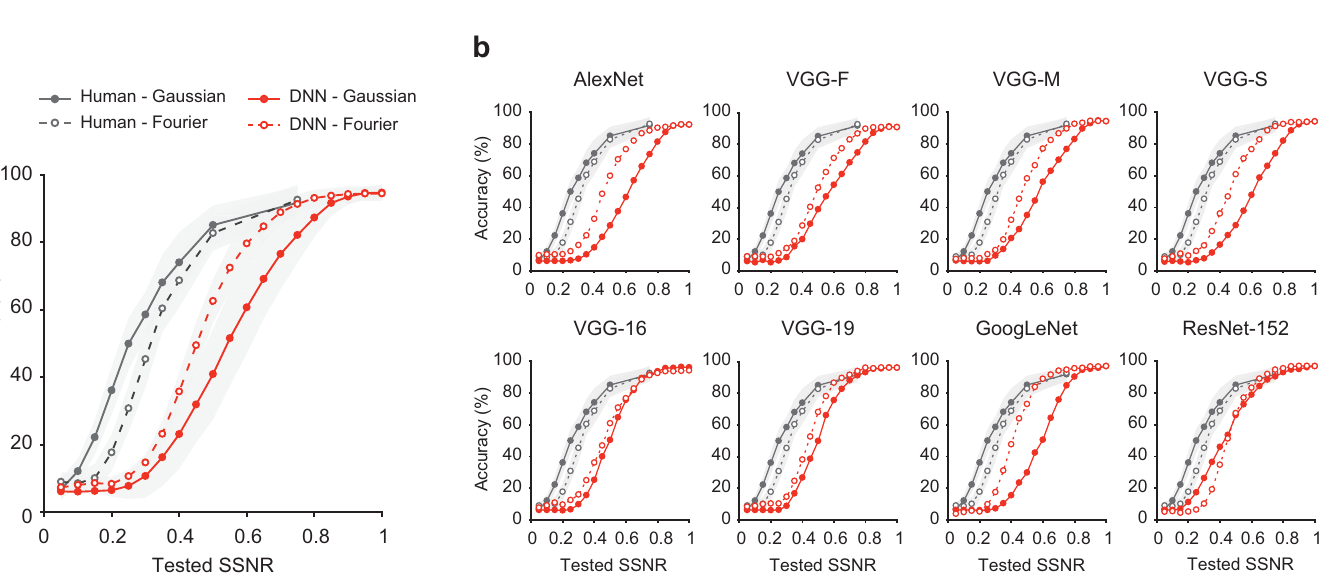
Fig 2. Humans outperform DNNs at recognizing objects in noise. (a) Mean performance accuracy in a 16-alternative object classification task plotted as a function of SSNR level for human observers (black curves) and 8 standard pretrained DNNs (red curves) with ± 1 standard deviation in performance indicated by the shaded area around each curve. Separate curves are plotted for pixelated Gaussian noise (solid lines with closed circles) and Fourier phase-scrambled noise (dashed lines with open circles). (b) Classification accuracy plotted as a function of SSNR level for individual pretrained DNN models. Data are available at https://osf.io/bxr2v/. DNN, deep neural network; SSNR, signal-to-signal-plus-noise